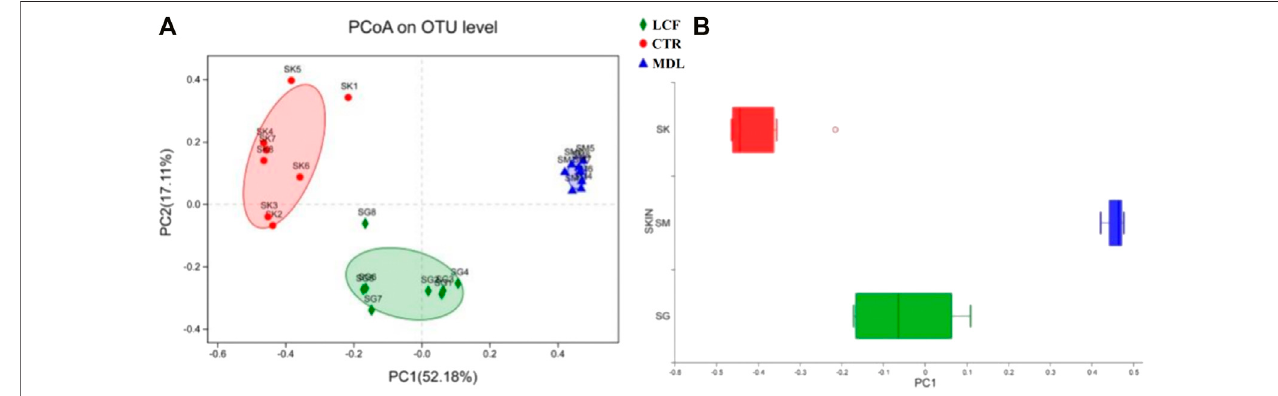
FIGURE9 | Beta diversity comparisons ofmicrobial communities ofCTR, MDL, and LCF. Displayed are (A) Primary coordinate analyses ofskin microbes samples of abundance UniFrac distances between samples from LCF, MDL, and LCF, and (B) Discrete box plot of grouped samples on the PC1 axis of PcoA.